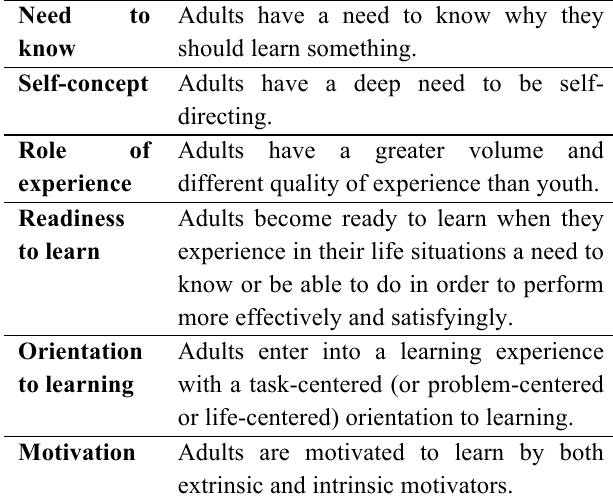
Table 3. Assumptions about adult learners [26][27] Need to should learn